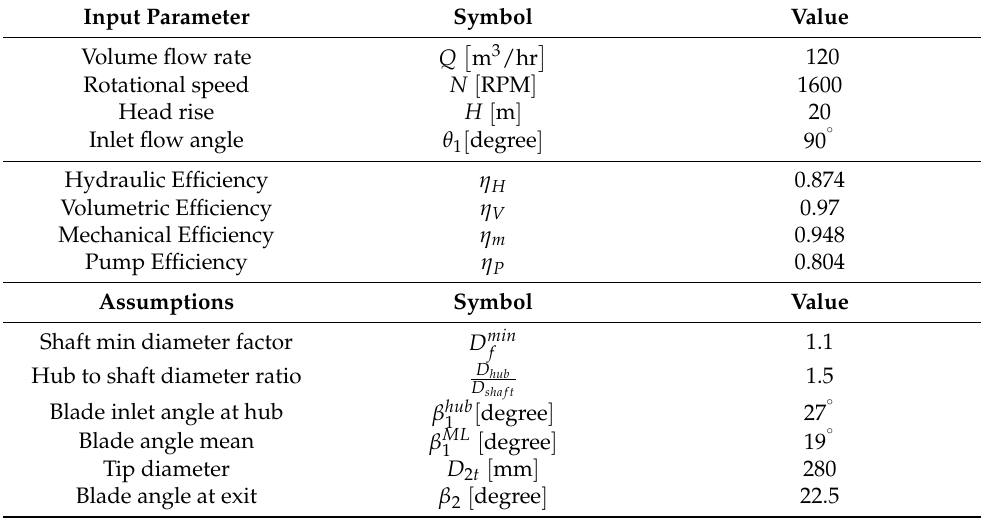
Table 1. Input parameter and